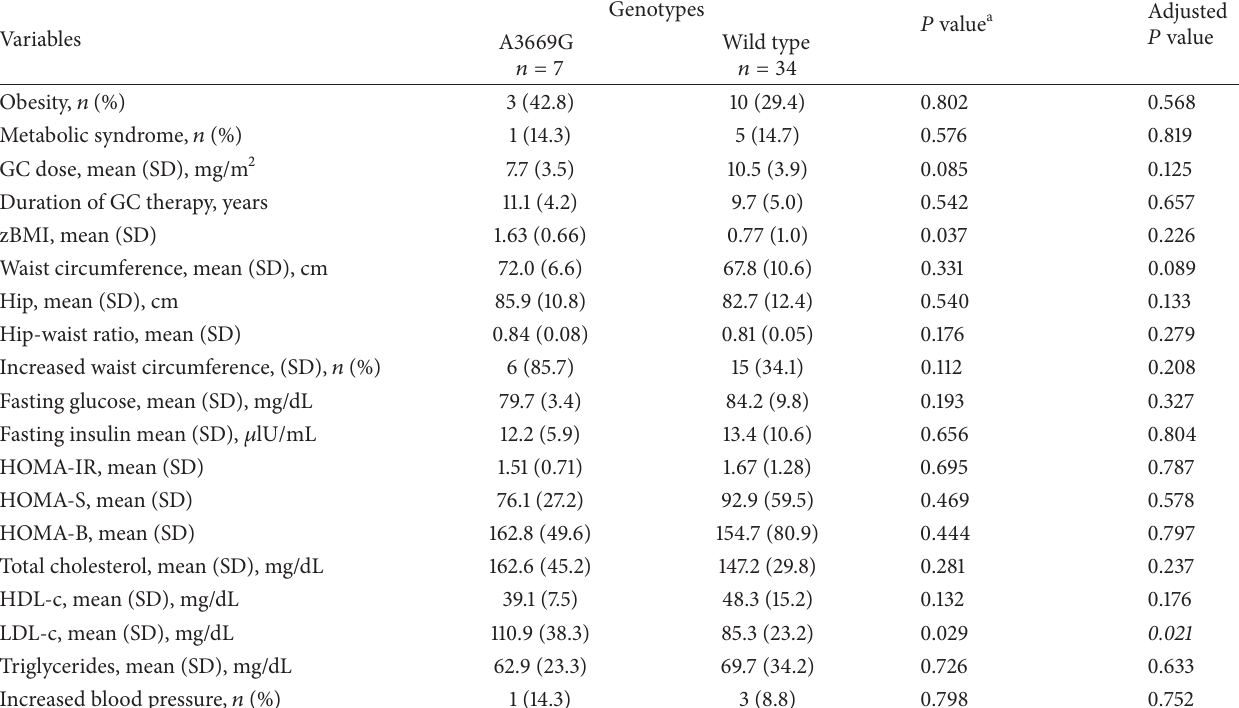
Table 2: Influence of A3669G polymorphism on the metabolic profile of CAH